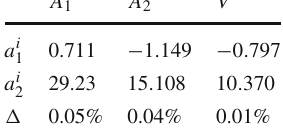
Table 5 The fitted parameters a i for the D → ρ TFFs F i , in 1 , 2 which all the LCSR parameters